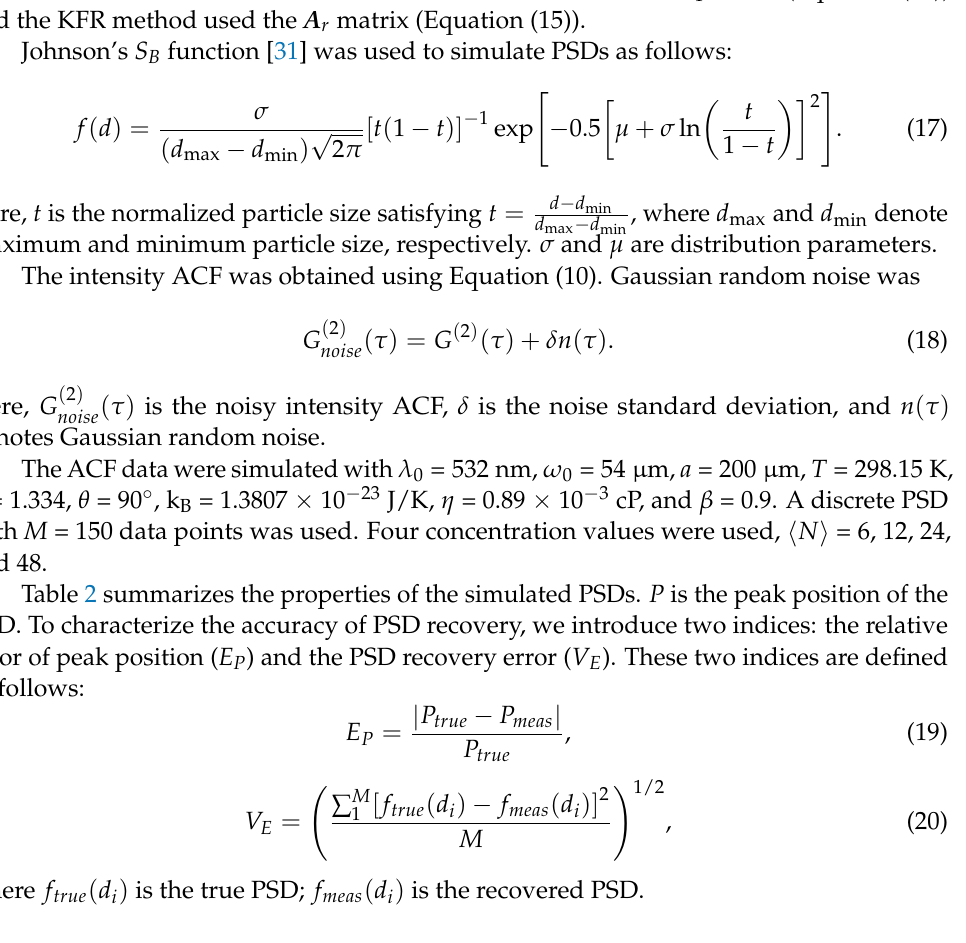
Table 2. Parameters and properties of the simulated